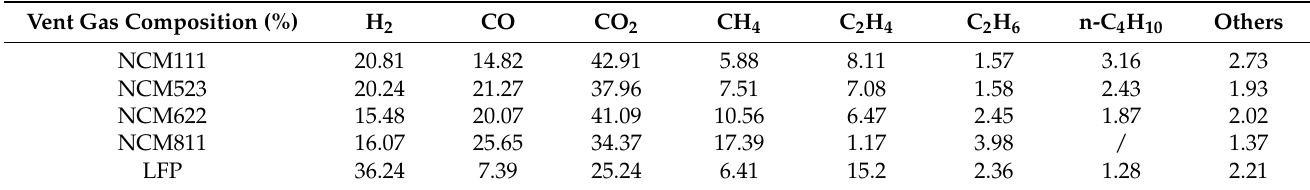
Table 2. TR gas components of LIBs with different cathode materials